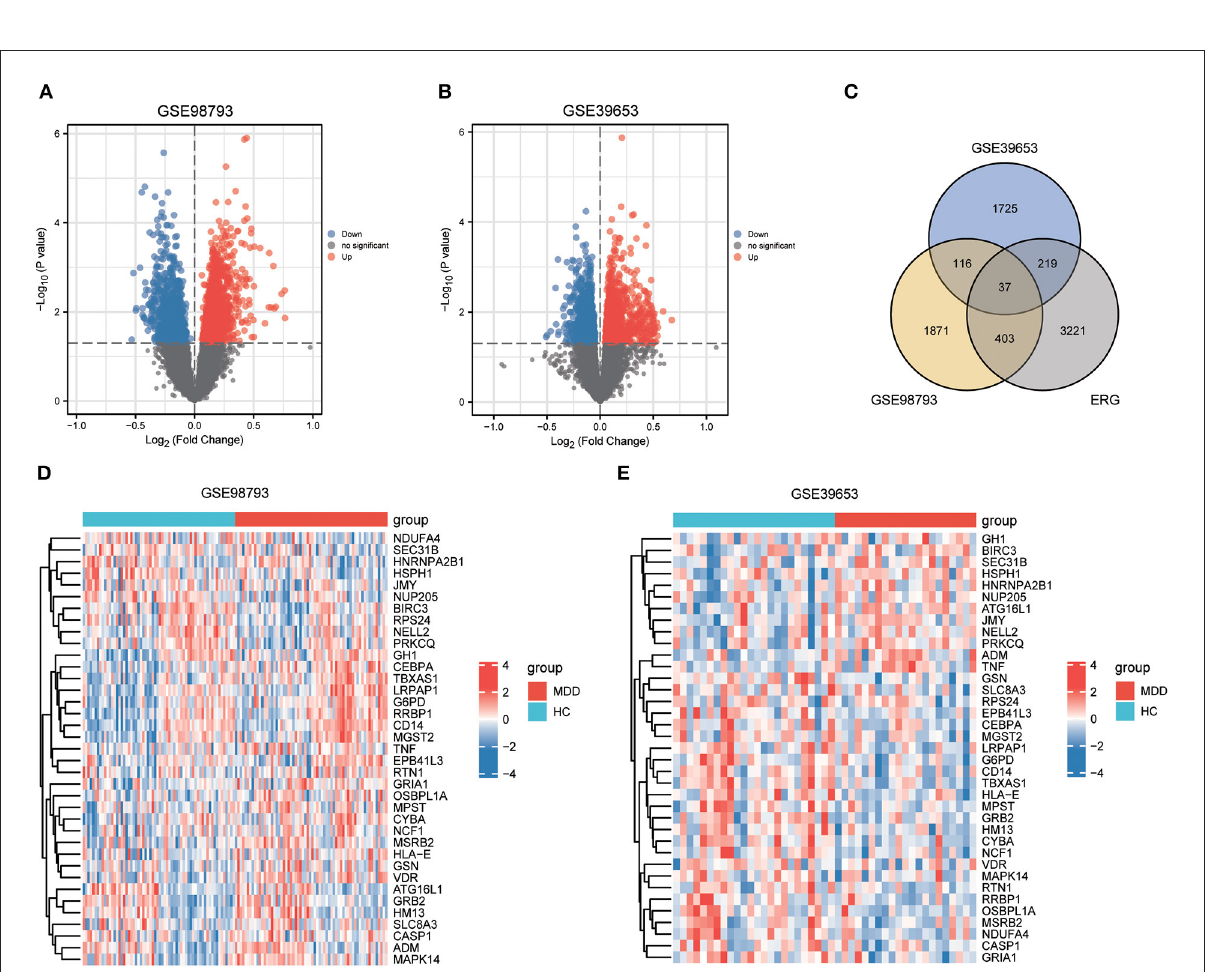
FIGURE4 Endoplasmic reticulum stress-related gene (ERSR-DEGs) expressions. (A) Volcano plot of GSE98793. (B) Volcano plot of GSE39653. (C) Venn diagram for overlapping ERSR-DEGs based on 3 datasets. (D) Heatmap of ERSR-DEGs identified in GSE98793. (E) Heatmap of ERSR-DEGs identified in